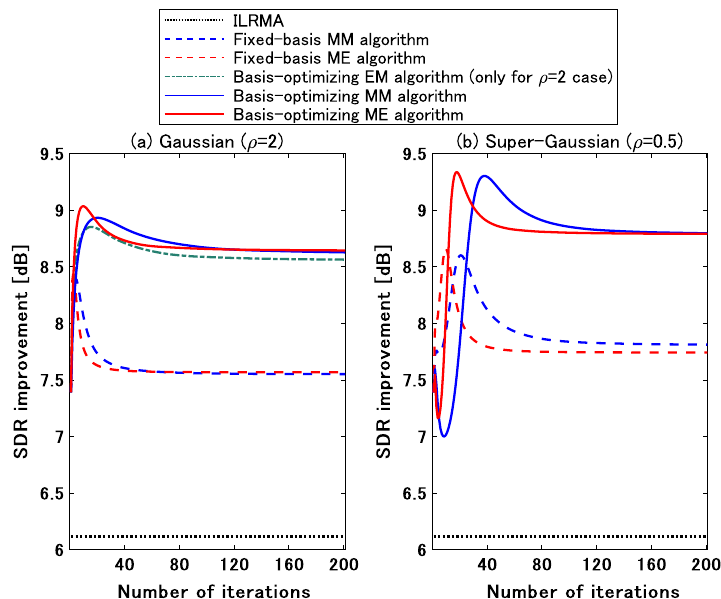
Fig. 3 Behavior of SDR improvements under the babble noise condition. SDR improvements are averaged over six speech sources, four target directions, and 10 parameter-initialization random seeds. The shape parameter ρ in GGD is set to ( a ) 2 (Gaussian) and ( b ) 0.5 (super-Gaussian)